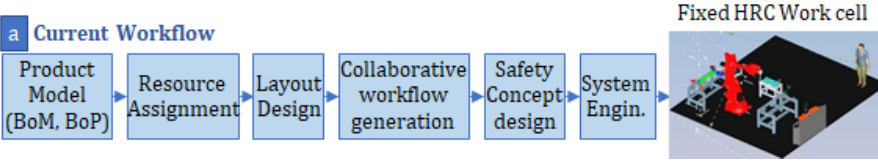
Figure 3. Current practice on the design workflow of HRC applications.